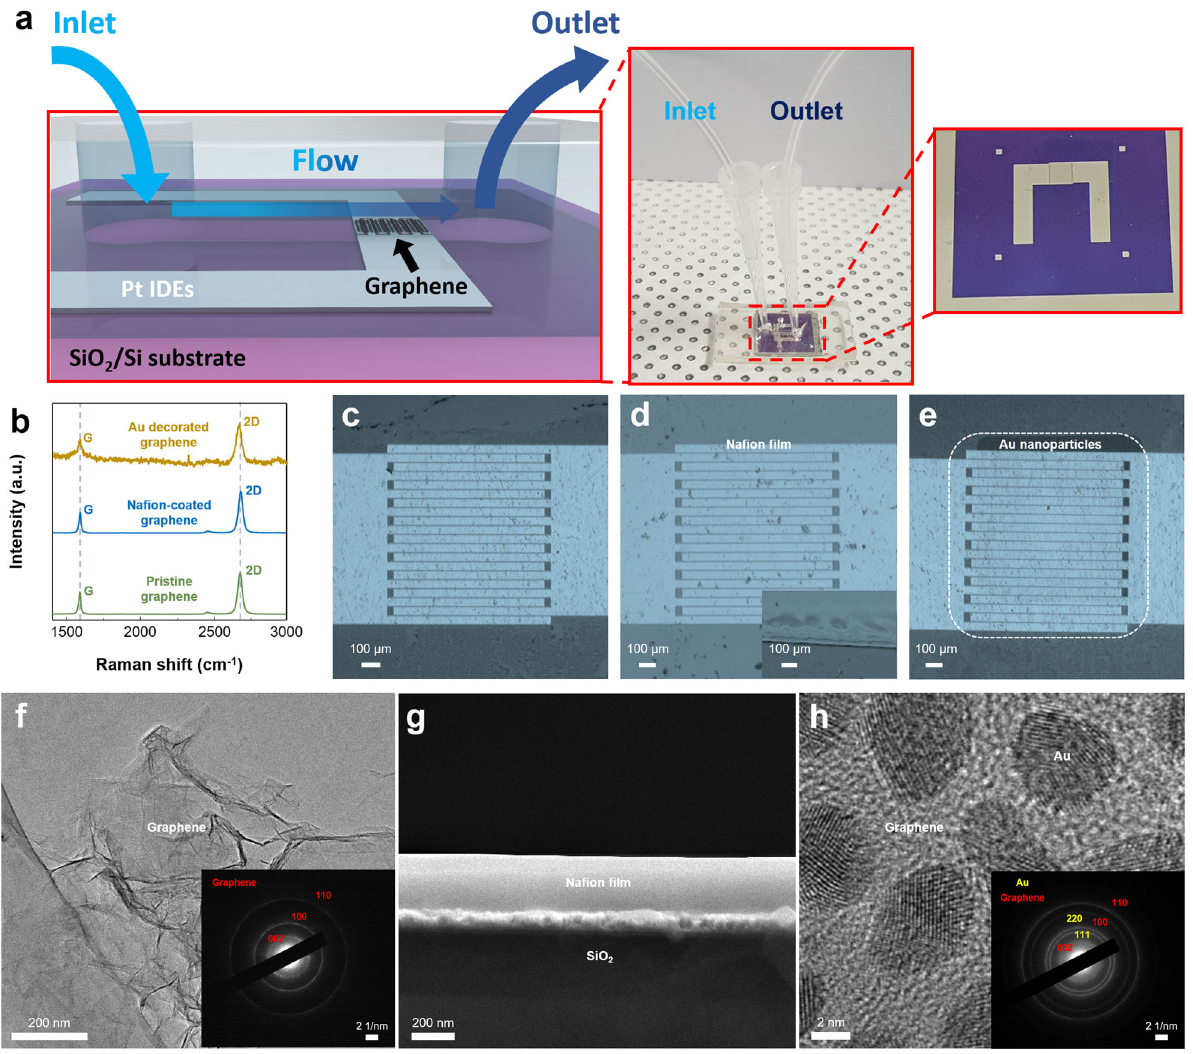
Fig. 2 Experimental setup and characterization of pristine, Na fi on-coated, and Au-decorated graphene. a Magni fi ed scheme and real image of the micro fl uidic channel device illustrating the inlet and outlet of the solution. b Raman spectroscopy of pristine, Na fi on-coated, and Au-decorated graphene. The peaks show that the graphene is not in fl uenced by Na fi on coating or Au decoration. OM images of c pristine graphene, d Na fi on-coated graphene, and e Au-decorated graphene. f TEM image of CVD grown pristine graphene. The inset shows the SAED patterns of pristine graphene. g Cross-sectional SEM image of Na fi on-coated graphene. h TEM image of Au-decorated graphene. The inset shows the SAED patterns of Au-decorated